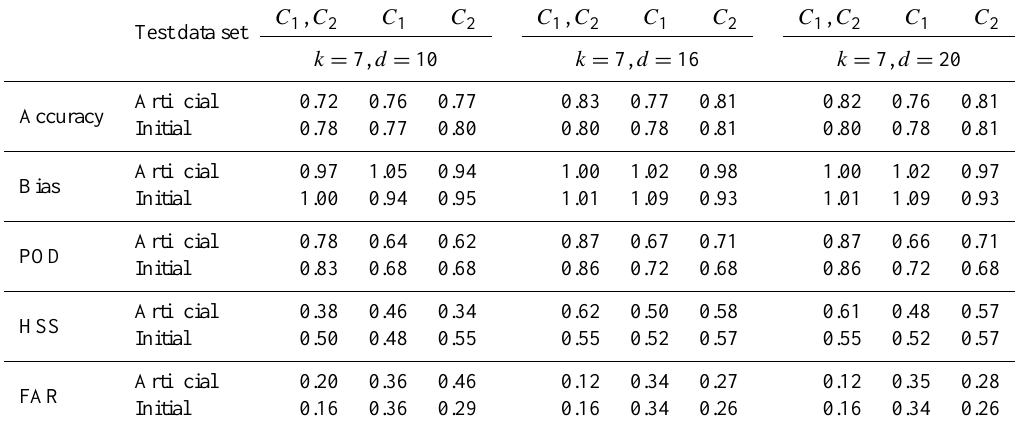
Table 4. Statistical scores related to the RainCEIV rain rate results in classifying the initial and artificial test data set for k = 7. The statistical scores are shown for all the rainy classes ( C 1 , C 2 ) , light to moderate rain ( C 1 ) , and heavy to very heavy rain ( C 2 ) .